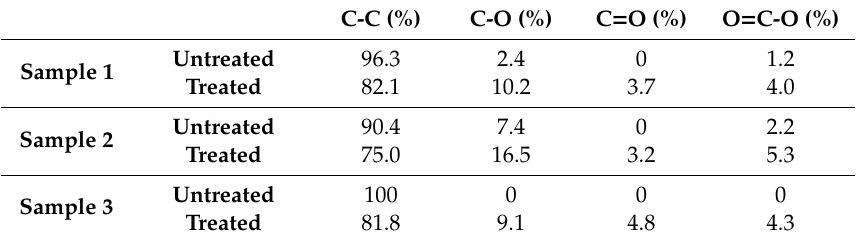
Figure 3. High resolution XPS spectra of plasma treated Sample 3. Table 2. Deconvolution of high resolution carbon (C1s)